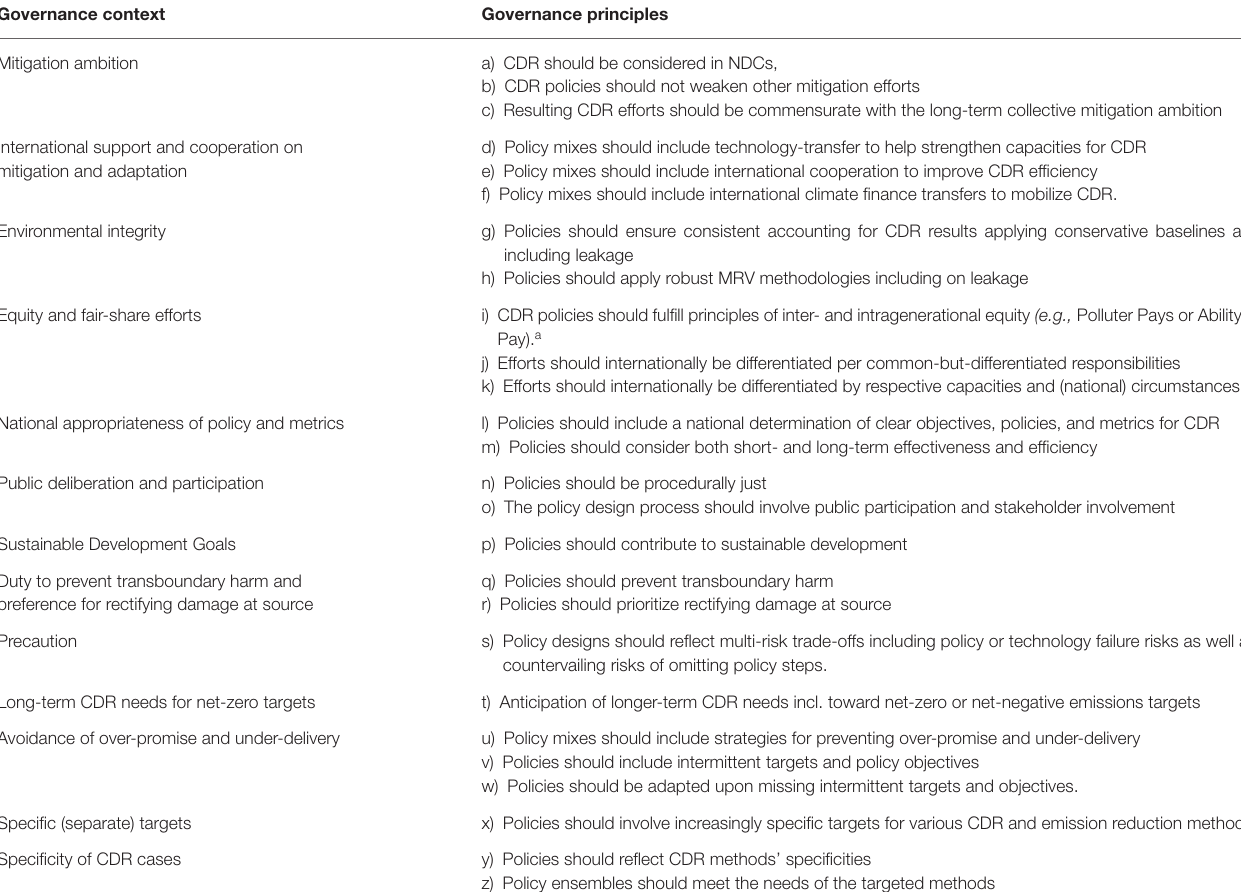
TABLE 1 | The ABC of potential governance